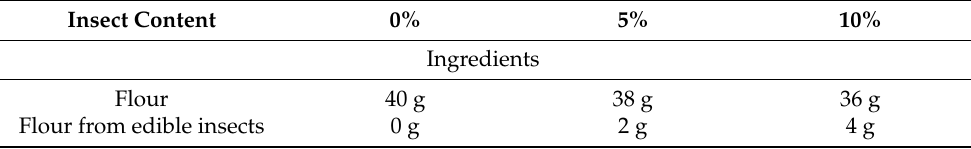
Table 3. Content of insect flour and weights of individual raw materials for sample production— monitoring dough leavening with the addition of edible insect flour ( Tenebrio molitor